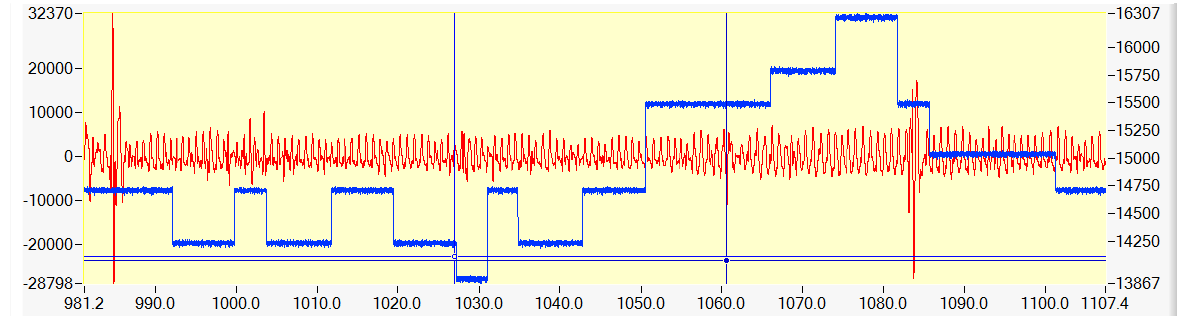
Fig. 4. CO 2 inhalation . REG signal (red) after filtering; NIRS (blue). Time of inhalation indicated by vertical lines (blue). REG amplitude increase was 179.23 % of baseline (before test), in identical time with NIRS. Y-axis is AD conversion units; X-axis is in seconds.